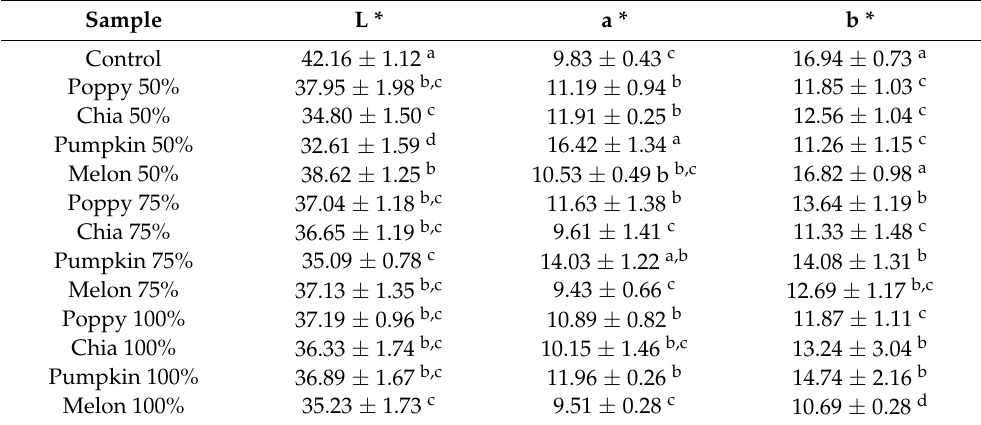
Table 3. Results obtained for the color parameters of the chorizos prepared with different emulsified seed oils.